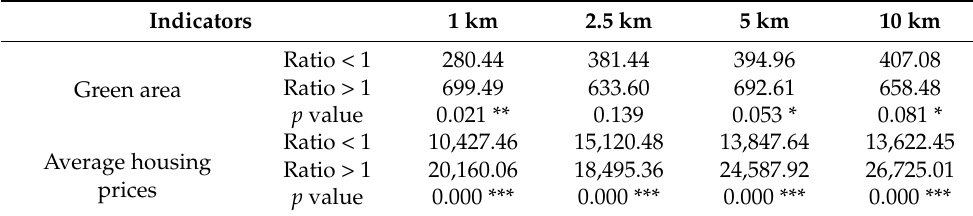
Table 3. T -test results of green area and average housing price for cities with ratio > 1 and ratio <